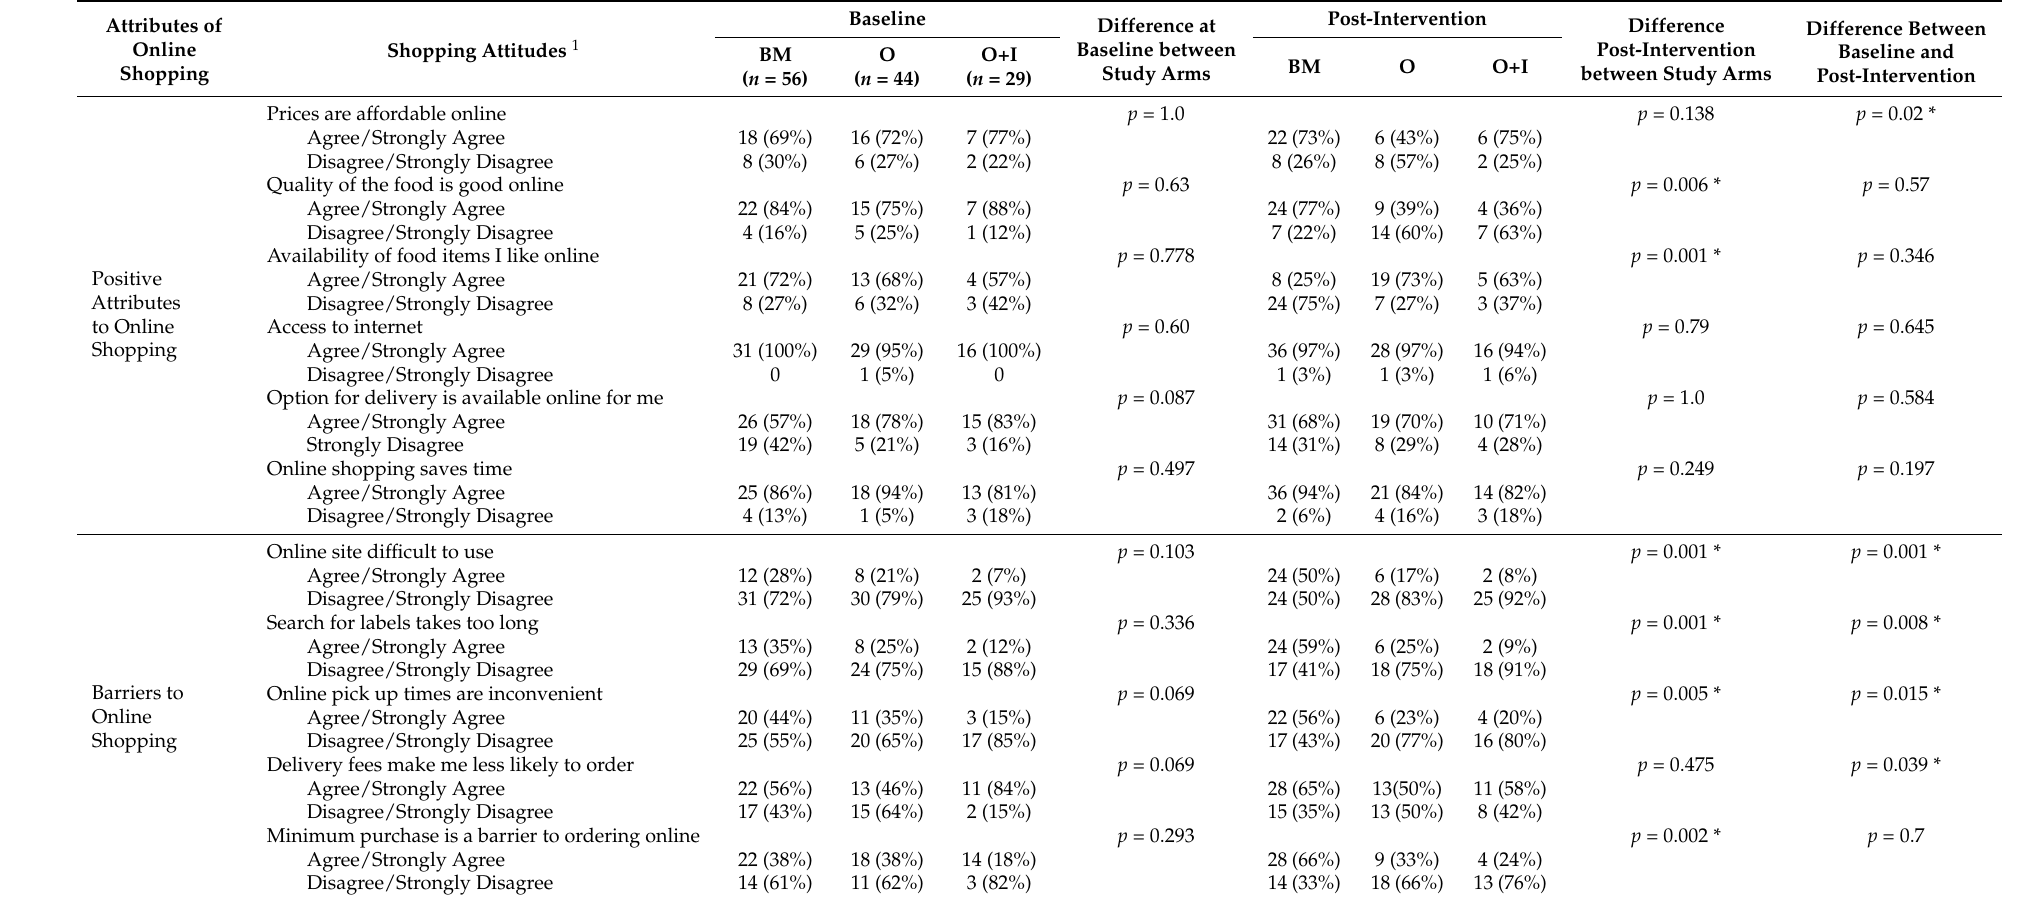
Table 5. Online shopping attitudes and barriers baseline and post-intervention across study